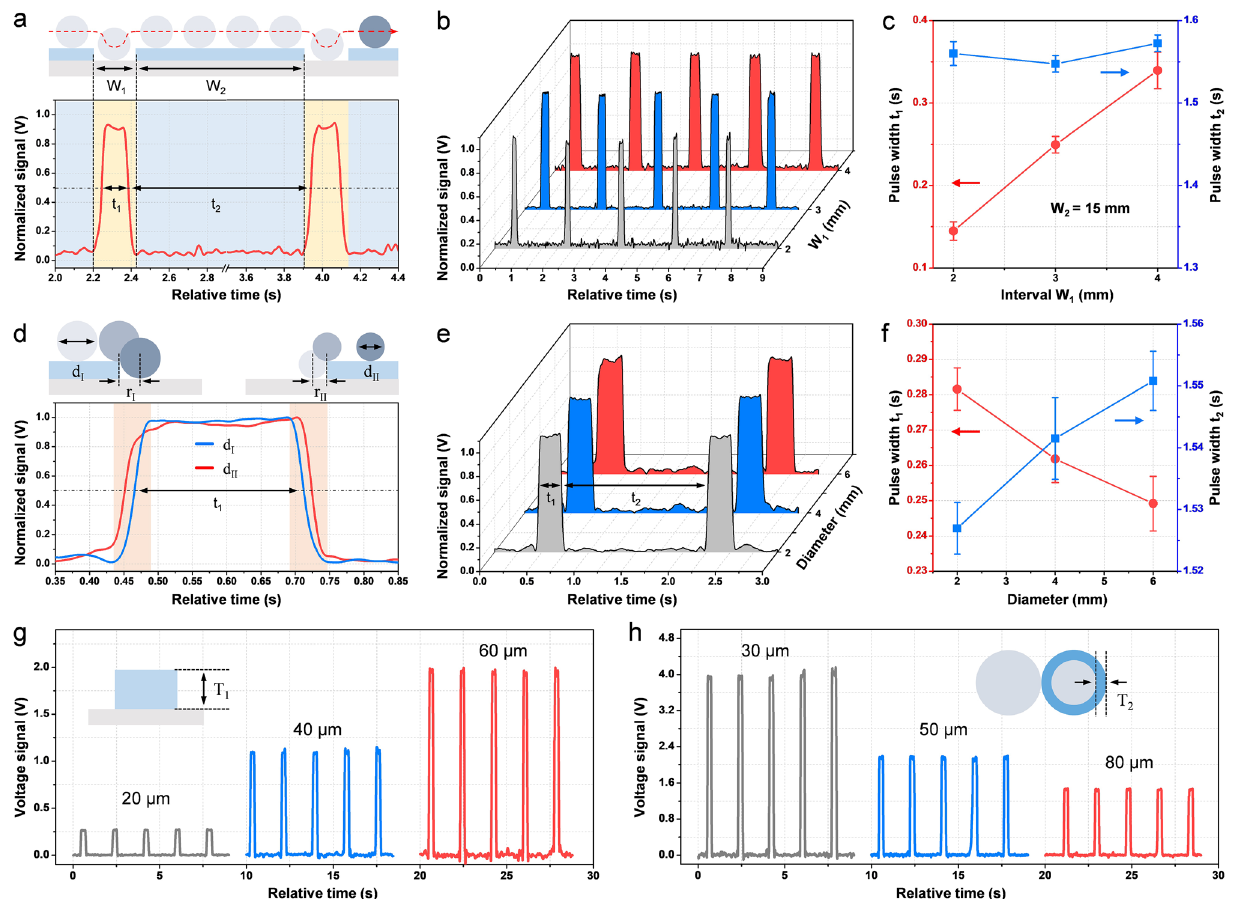
Fig. 2 Basic performance characterization of TLS. a Schematic and dynamic output signal of a typical sensing process ( W 1 = 2 mm, W W W t t 2 = 15 mm). b Sensing signals of TLS with different label intervals 1 and fixed label width 2 (15 mm). c Pulse time-width 1 and time-gap 2 of the sensing signal for different W 1 ( W 2 = 15 mm). d , e Schematic and dynamic output signal of TLS with different roller diameters ( d I = 6 mm, d t t II = 2 mm). f Pulse time-width 1 and time-gap 2 for different roller diameters. The influence of g label thickness and h tribo-layer thickness on the absolute output signal of